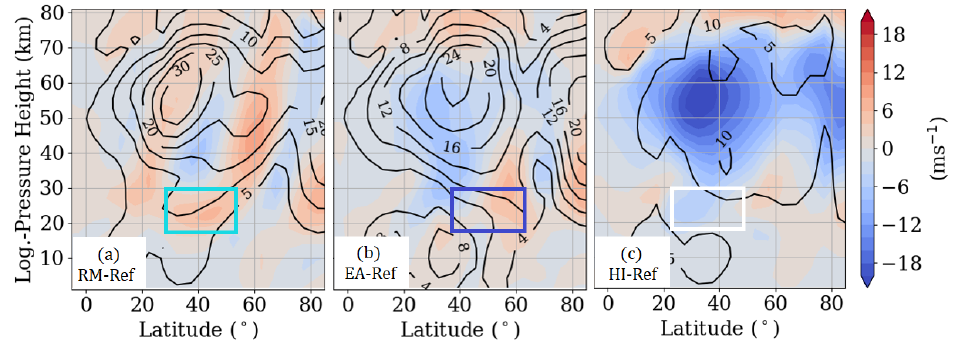
Figure 8. Stationary planetary wave 1 amplitude differences between the RM ( a ), HI ( b ), EA ( c ) experiments and the Ref simulation in color coding. The contour lines show the SPW 1 amplitude distribution of the respective GW hotspot. The color coding indicates the differences and the contour lines show the SPW 1 amplitude of the respective